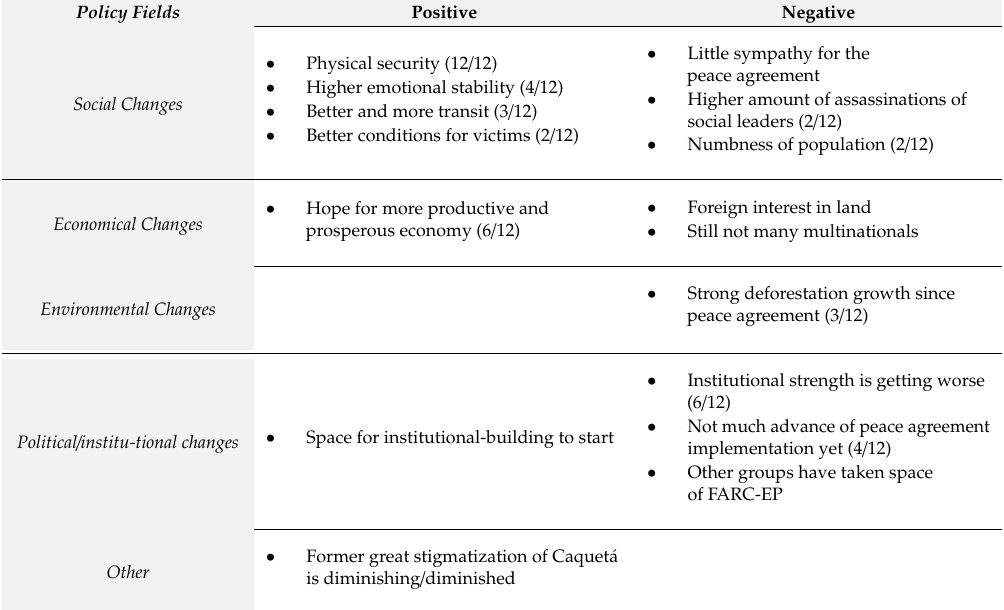
Table 3. Positive and negative perceptions from the peace implementation process (numbers in brackets show the number of interviewees who mentioned this